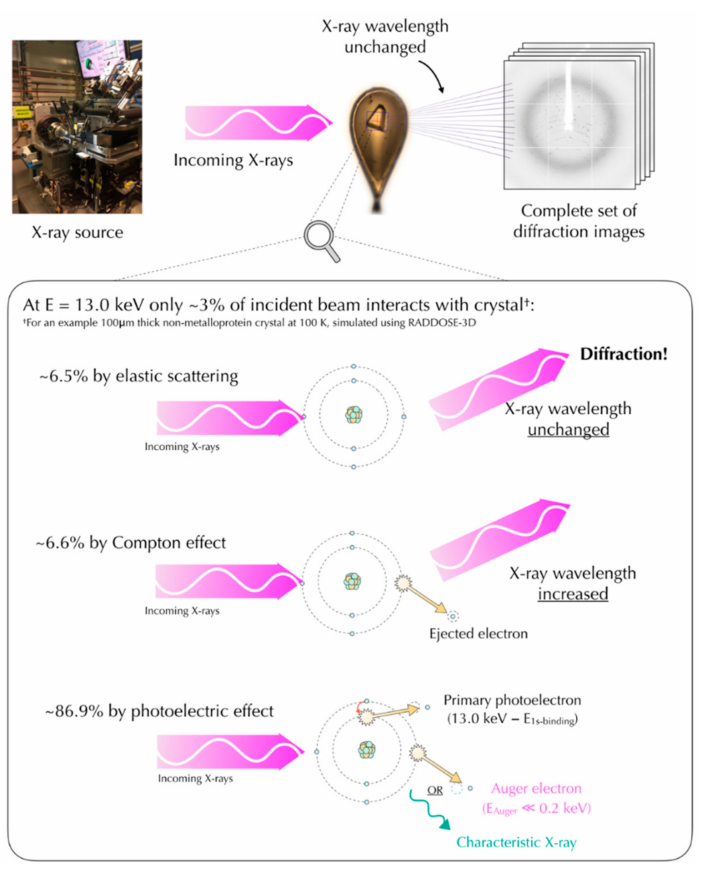
Figure 1. The different primary X-ray scattering processes of an incident 13.0 keV beam with an example lysozyme crystal simulated using